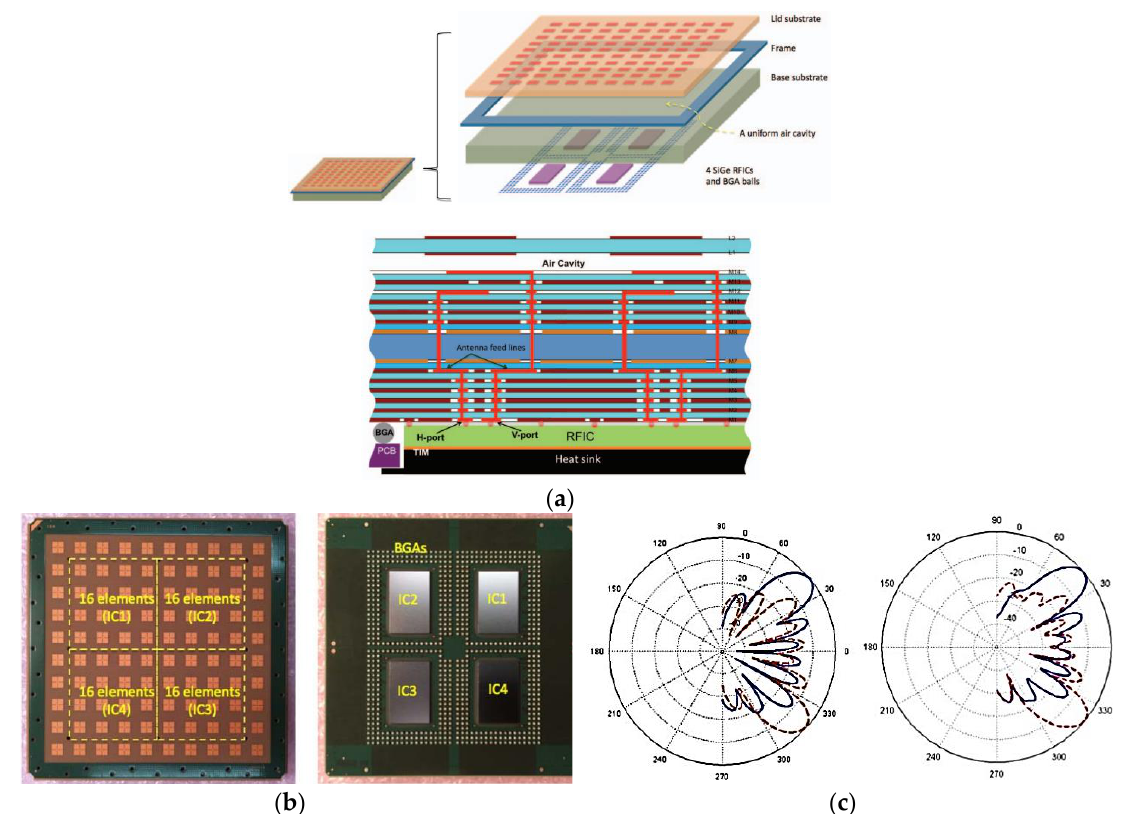
Figure 21. ( a ) Overview of antenna array assembly with transceiver ICs. ( b ) Photograph of the assembled antenna array package with four transceiver ICs. ( c ) 64-element TX phased-array angular beam-scanning of ± 40 ◦ (Redrawn from